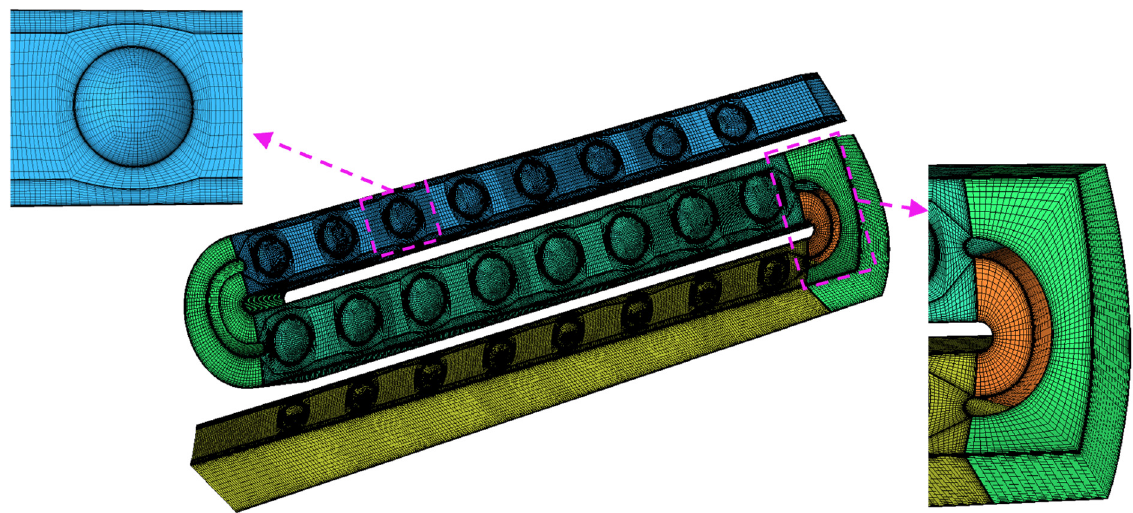
Figure 3. Grid of the case4 channel.